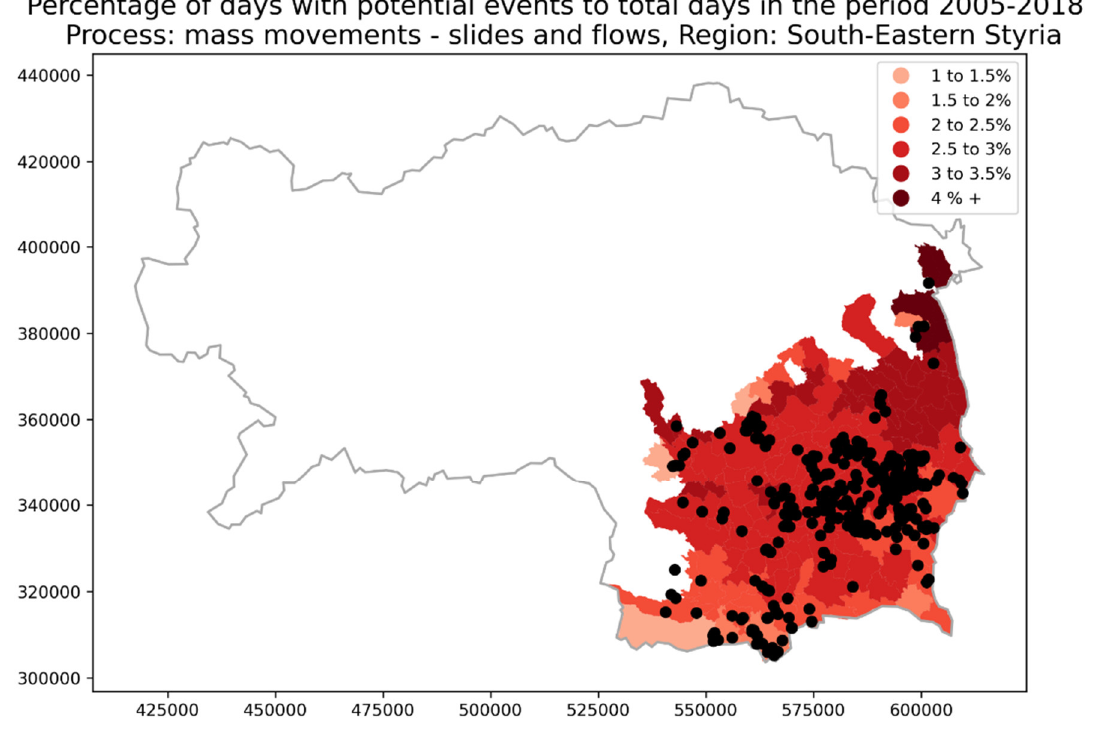
Figure 11. Percentage of days with potential events to total days in the considered period from 2005 to 2018 in the region south-eastern Styria. The process investigated refers to the hazard category “mass movements—slides and flows”.